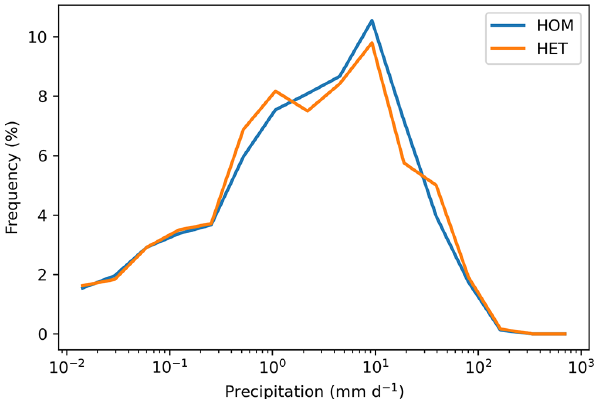
Figure 14. Daily precipitation simulated by HET configuration in